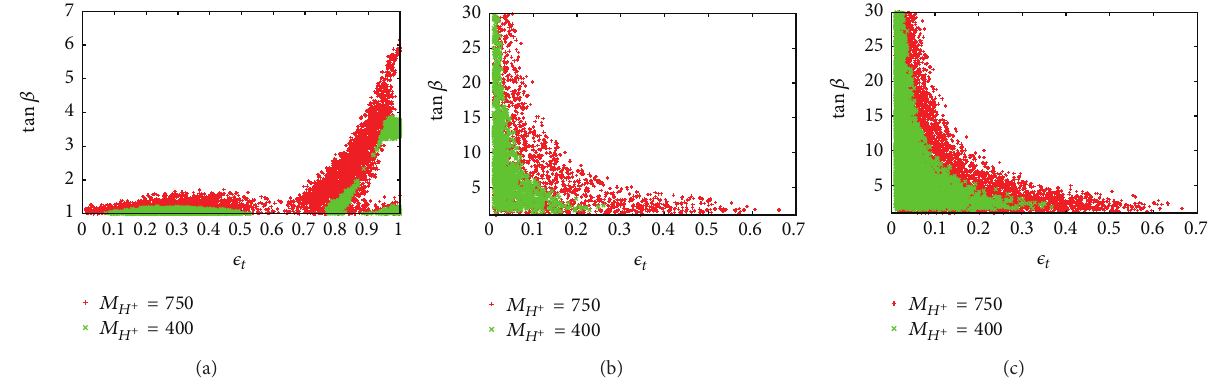
󸀠 | = 0.004 ): the allowed parameter space in the tan 𝛽 − 𝜖 𝑠𝑏